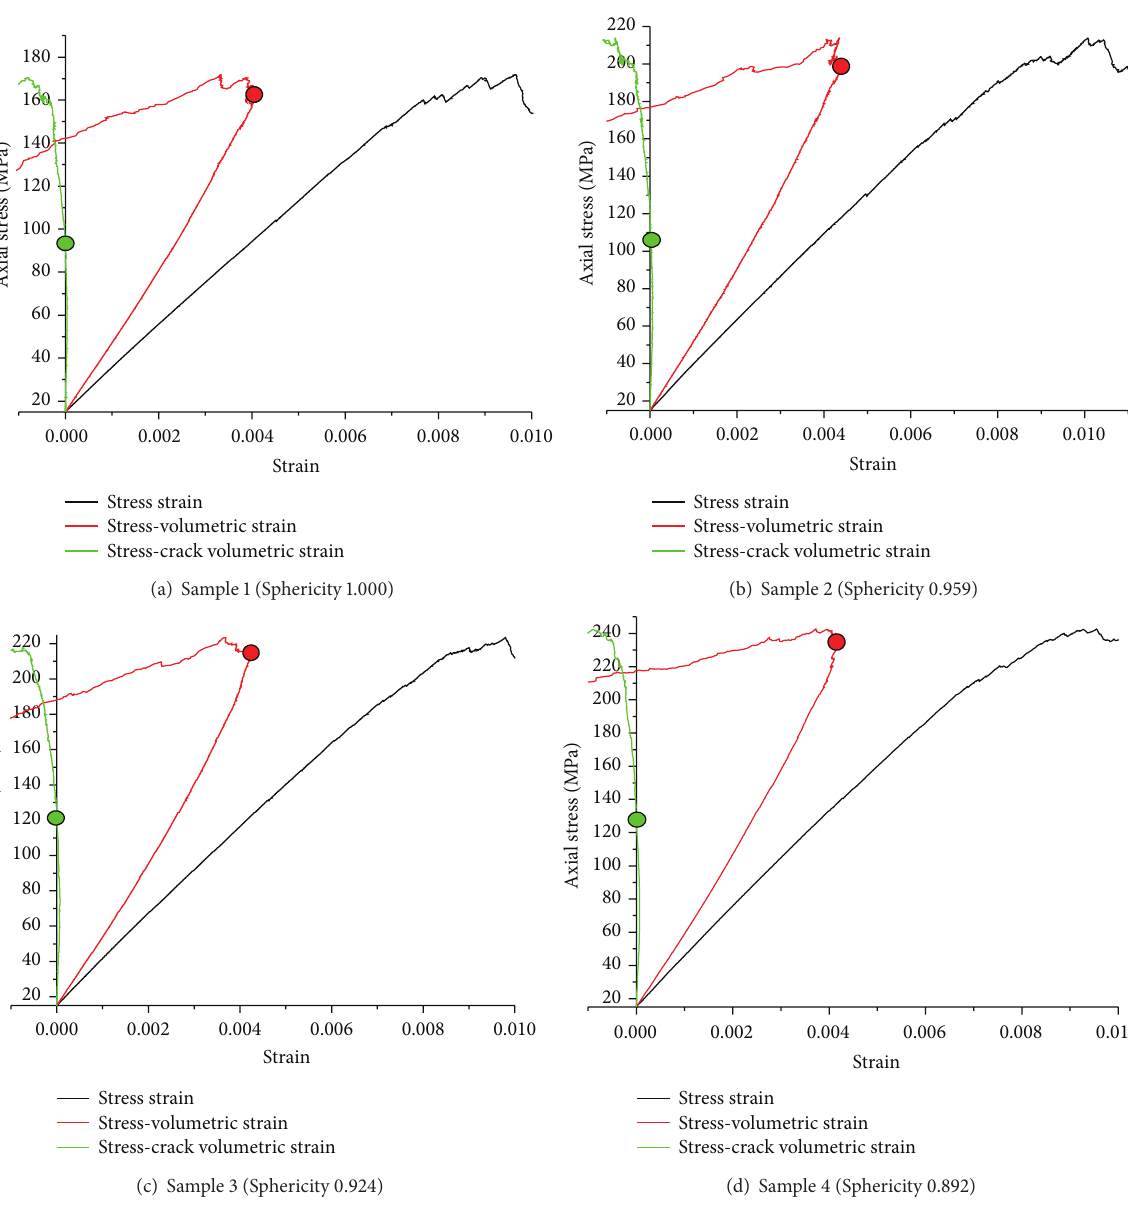
Figure 10: The crack initiation stress and crack damage stress of four rock